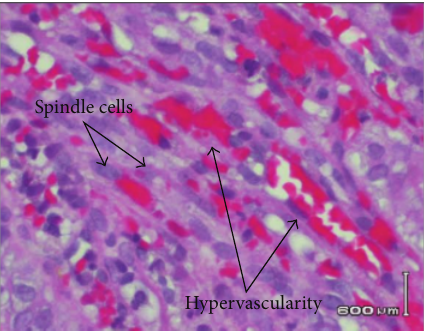
Figure 3: Gastric lesion biopsy displaying spindle cells and hyper- vascularity.